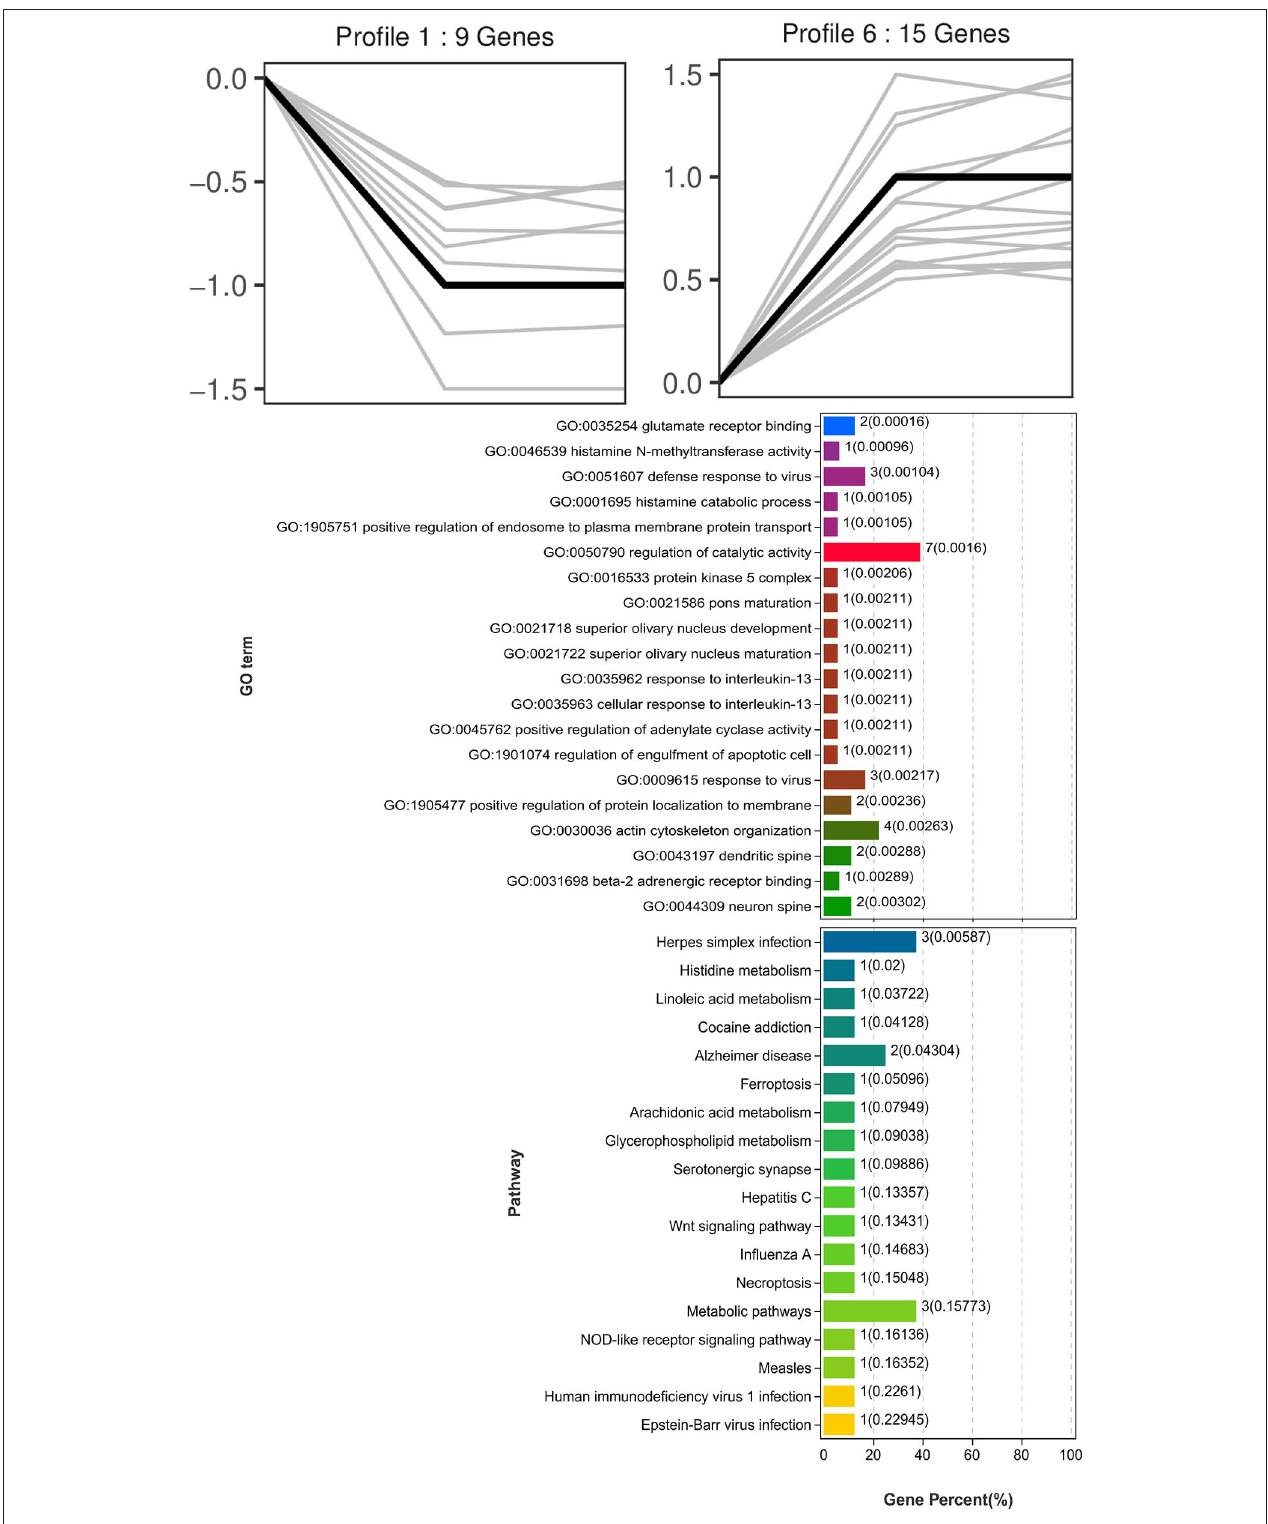
FIGURE 5 | GO and KEGG enrichment analysis of DEGs (in profile 1 and profile 6) with the LC response at BHBA-1.2 m M concentration.